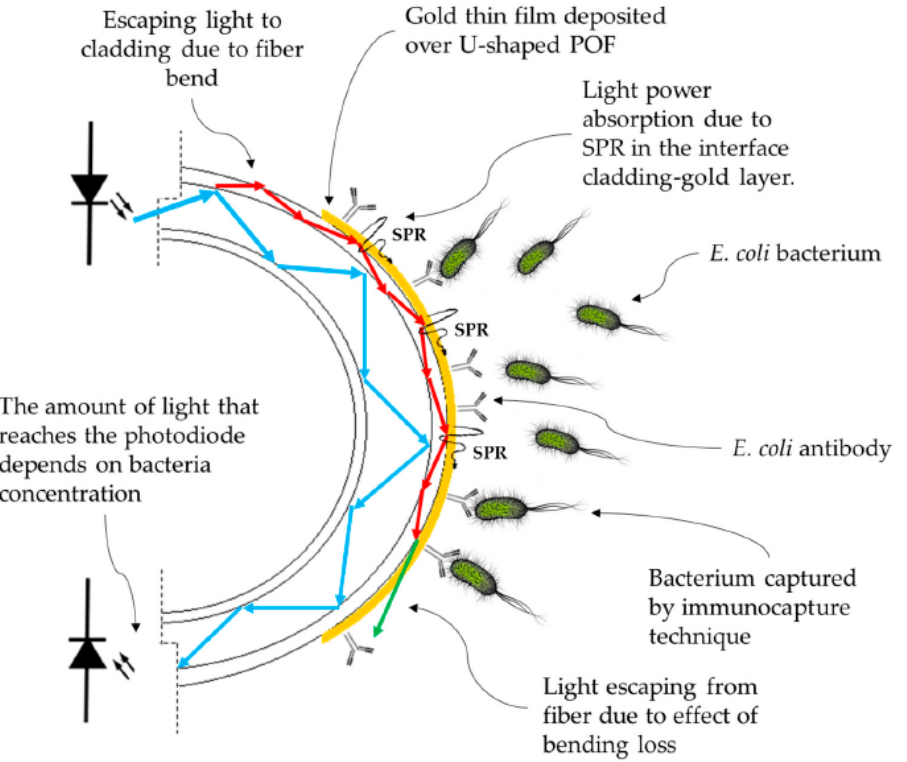
Figure 10. The working principle of gold-coated U-shaped plasmonic plastics-based optical fiber (POF) biosensor for detection of Escherichia coli ( E. coli ) bacteria. Figure reproduced under the terms of the CC-BY Creative Commons attribution 4.0 from Reference [35], Copyright 2018.